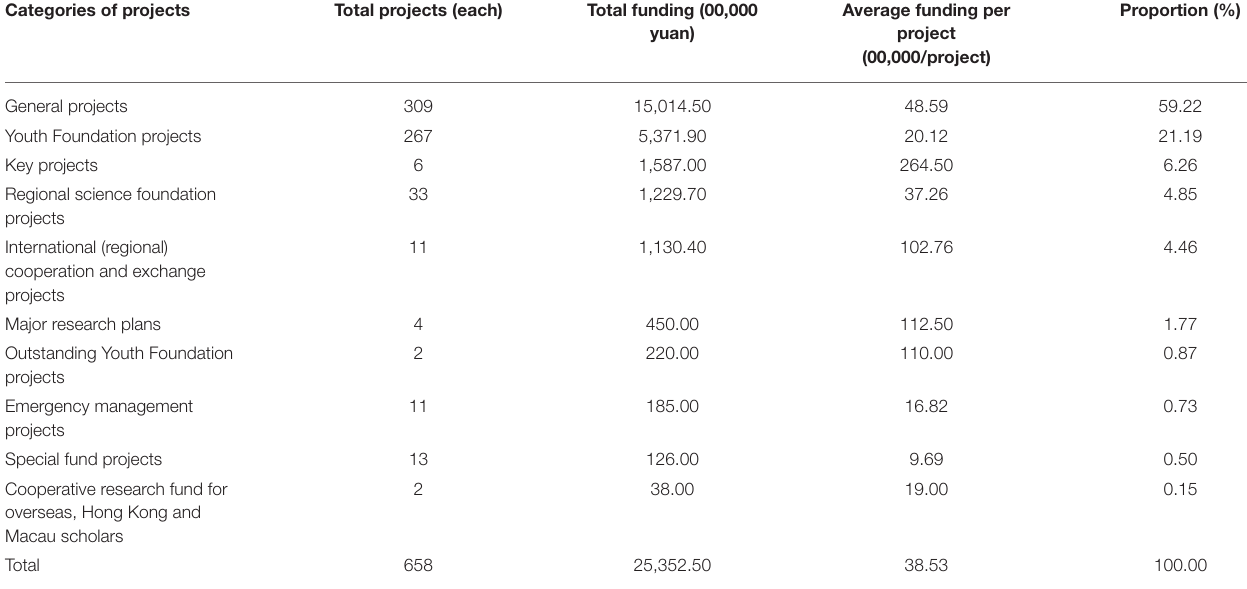
TABLE 2 | R&D input in rare diseases among the projects funded by